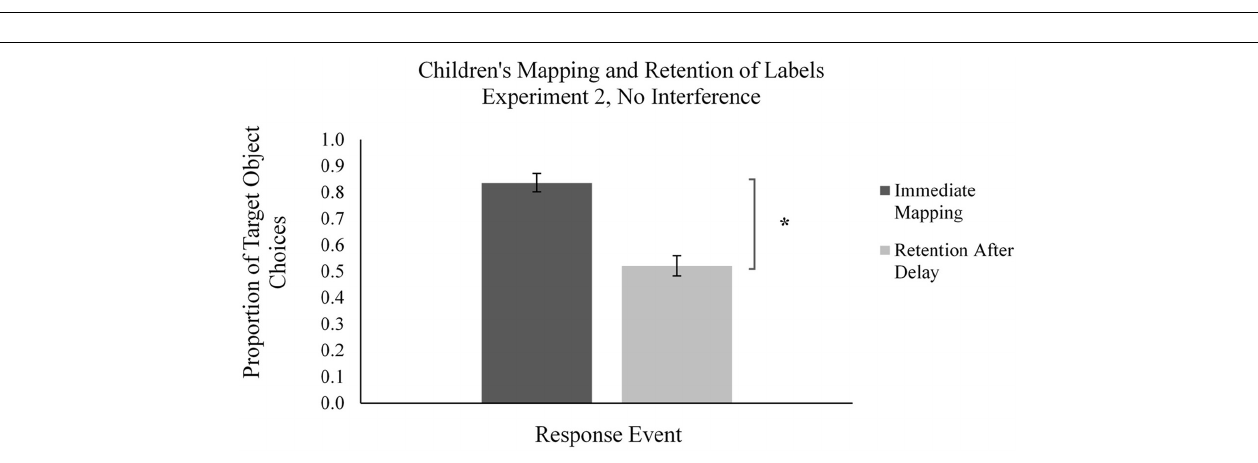
FIGURE 8 | Mean proportion of children’s target novel object choices in the learning phase (immediate mapping) and testing phase (retention after delay) for labels in the No Interference condition in Experiment 2. Error bars represent one standard error, * indicates significant difference in performance, p < 0.05.